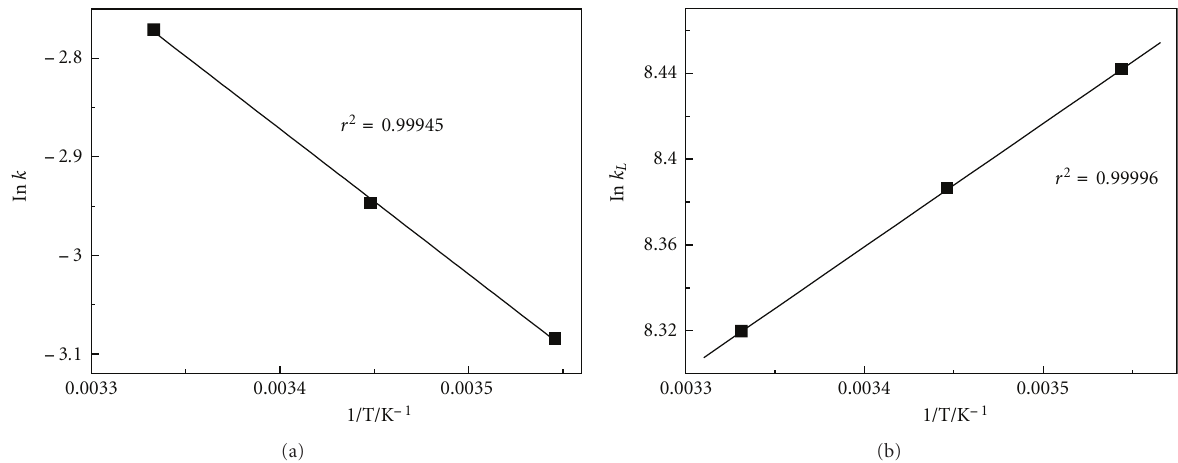
Figure 5: (a) Linear plot of ln k versus 1/T and (b) van’t Ho ff plot for the electrical removal of CuCl 2 onto CNT-CNF film